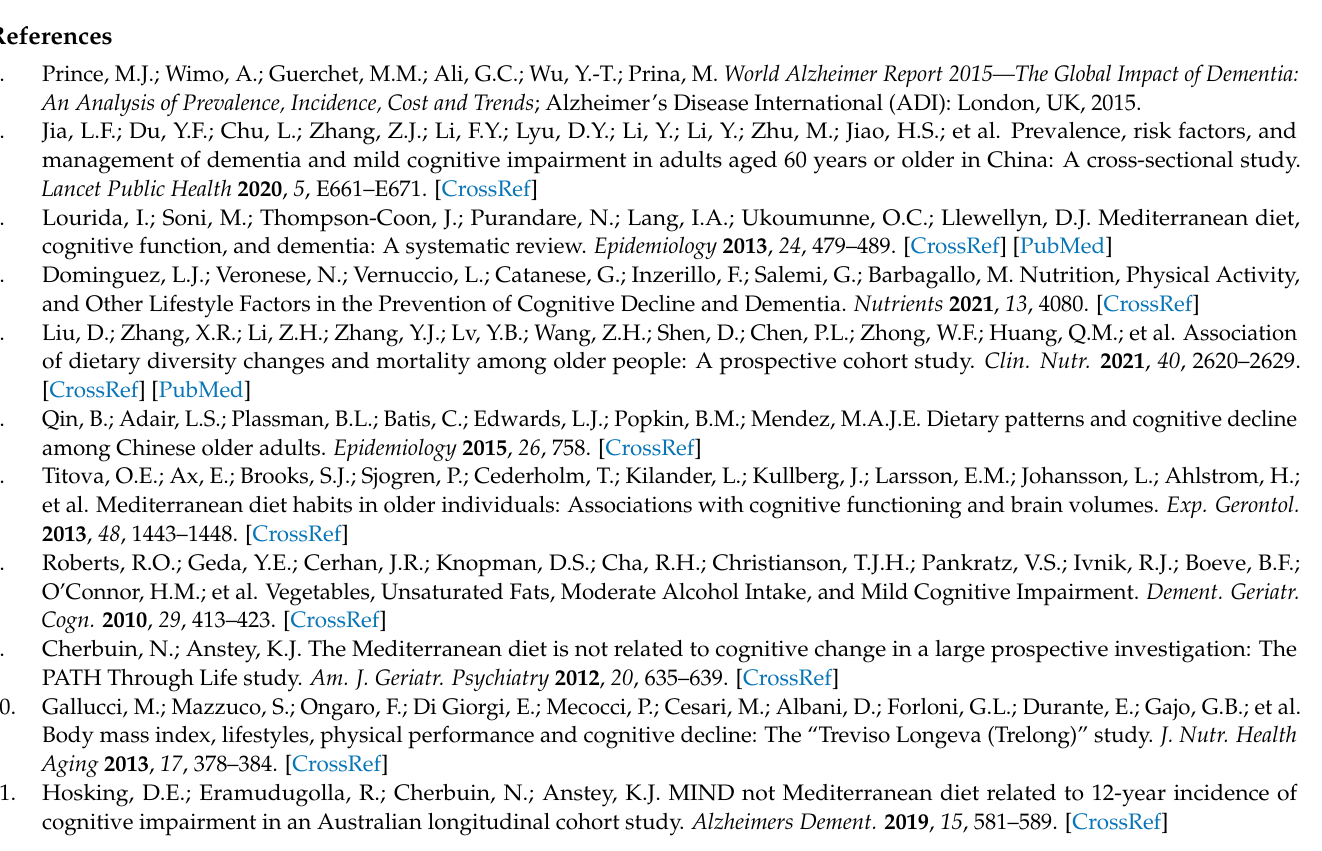
Table S5 Subgroup analysis for the association of DDS change with cognitive impairment; Table S6: Sensitivity